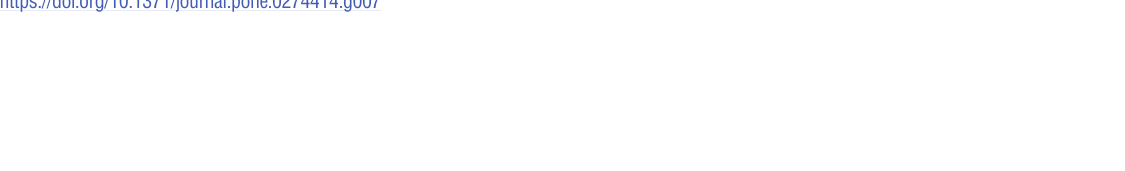
PLOS ONE | https://doi.org/10.1371/journal.pone.0274414 September 16,